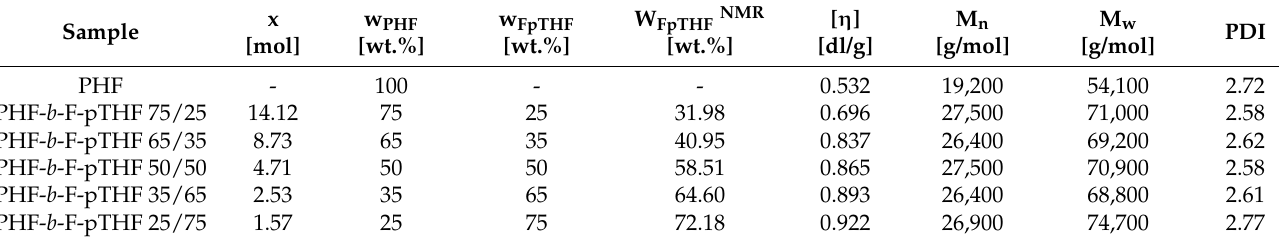
Table 1. Compositionand molecularcharacterization ofpoly(hexamethylene2,5-furanodicarboxylate)-block-poly(tetrahydrofuran) (PHF- b -F-pTHF)